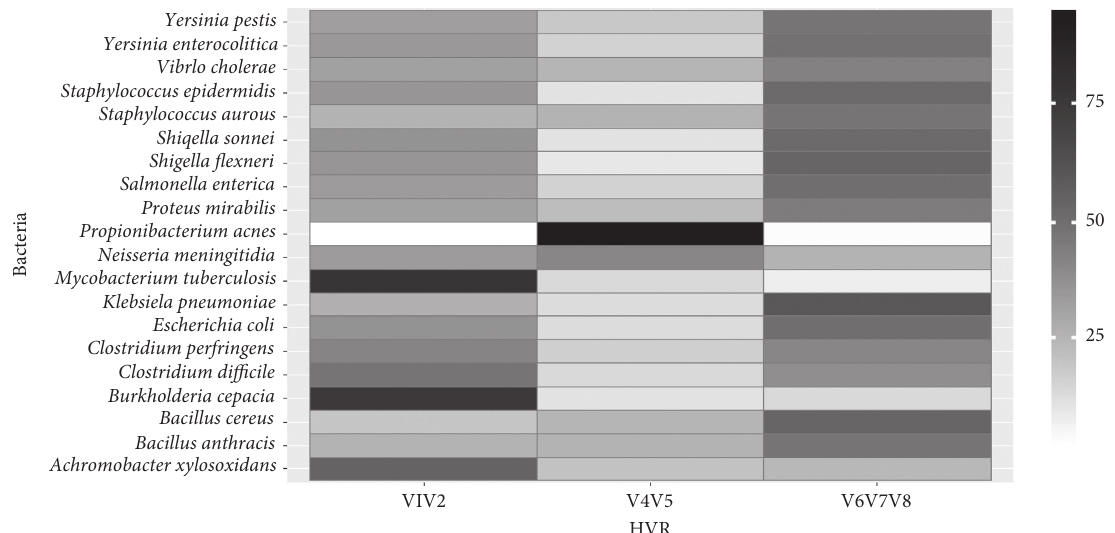
Figure 2: Percentage distribution of the reads mapped to 16S rRNA gene hypervariable regions (V1V2), (V4V5), and (V6V7V8) from a mock community containing 20 bacterial gDNA sequenced in Illumina MiSeq platform. Percentage of reads mapped to the respective bacterial 16S rRNA gene reference (similarity value �